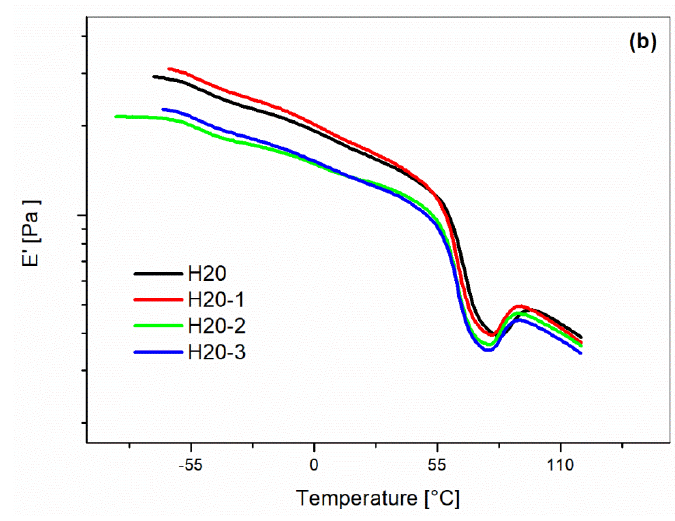
Figure 14. Dynamic mechanical analysis of the H20 blends as a function of the recycling cycle: ( a ) Tan δ and ( b ) Storage Modulus (E ′ ).